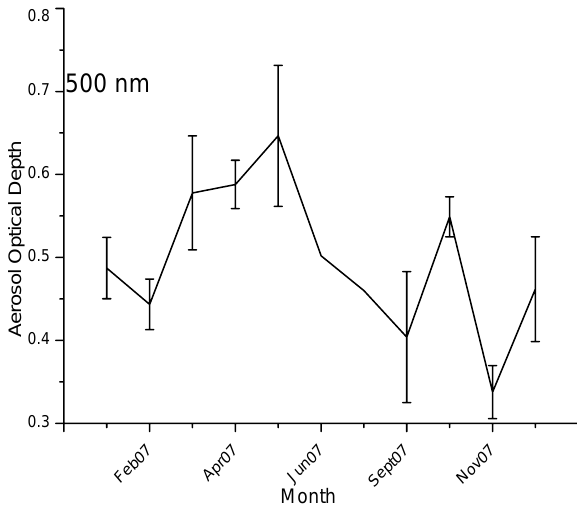
Fig. 6. Monthly variation of mean AOD (at 500nm) along with standard deviation measured using MICROTOPS II Sun photometer.